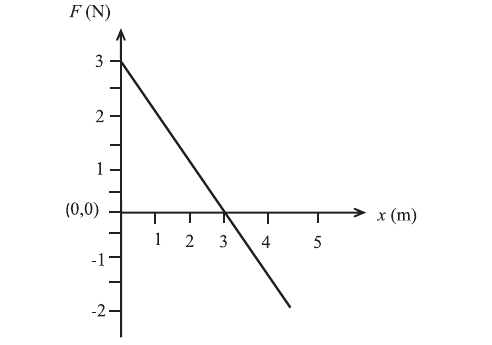
FIG. 3. Force-position graph requesting qualitative solution.